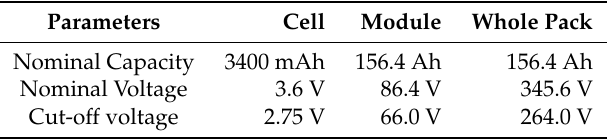
Table 3. Electrical parameters of the battery